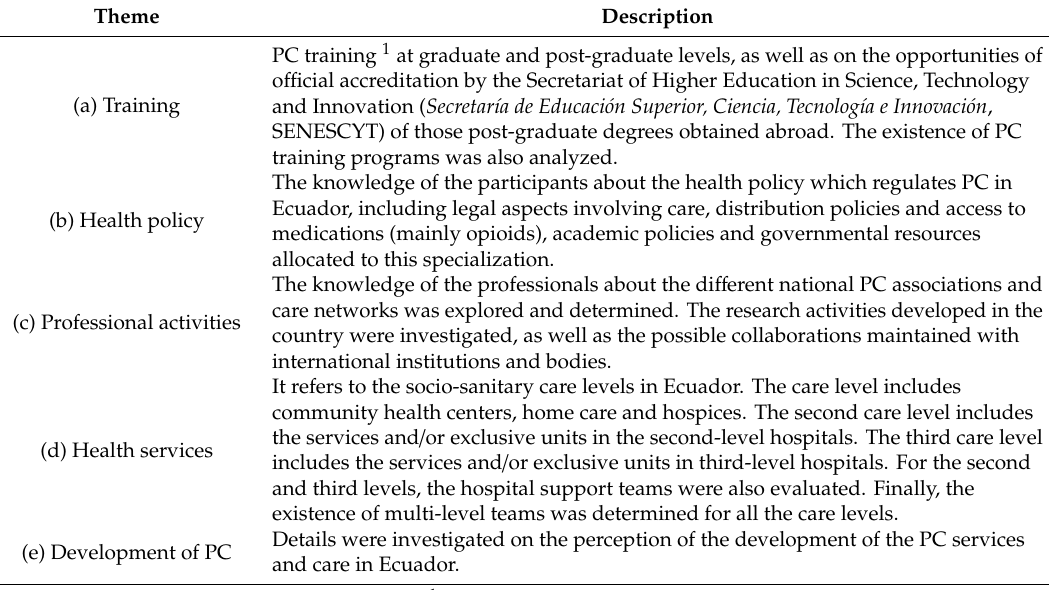
Table 3. Relation of the identified